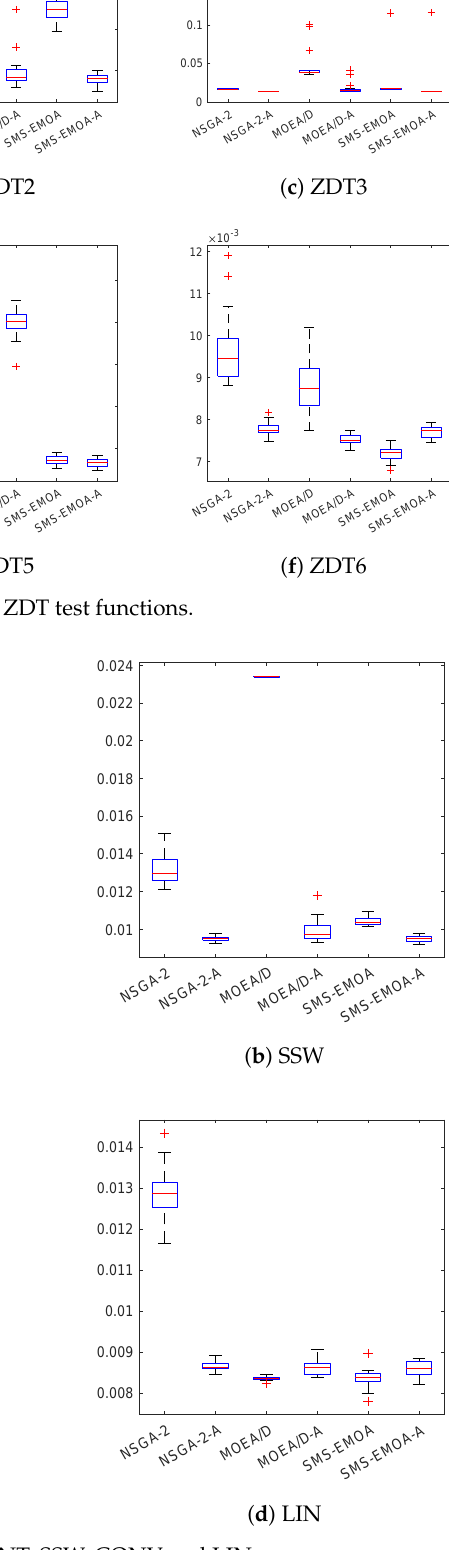
Figure 14. Boxplots for the obtained results for DENT, SSW, CONV and